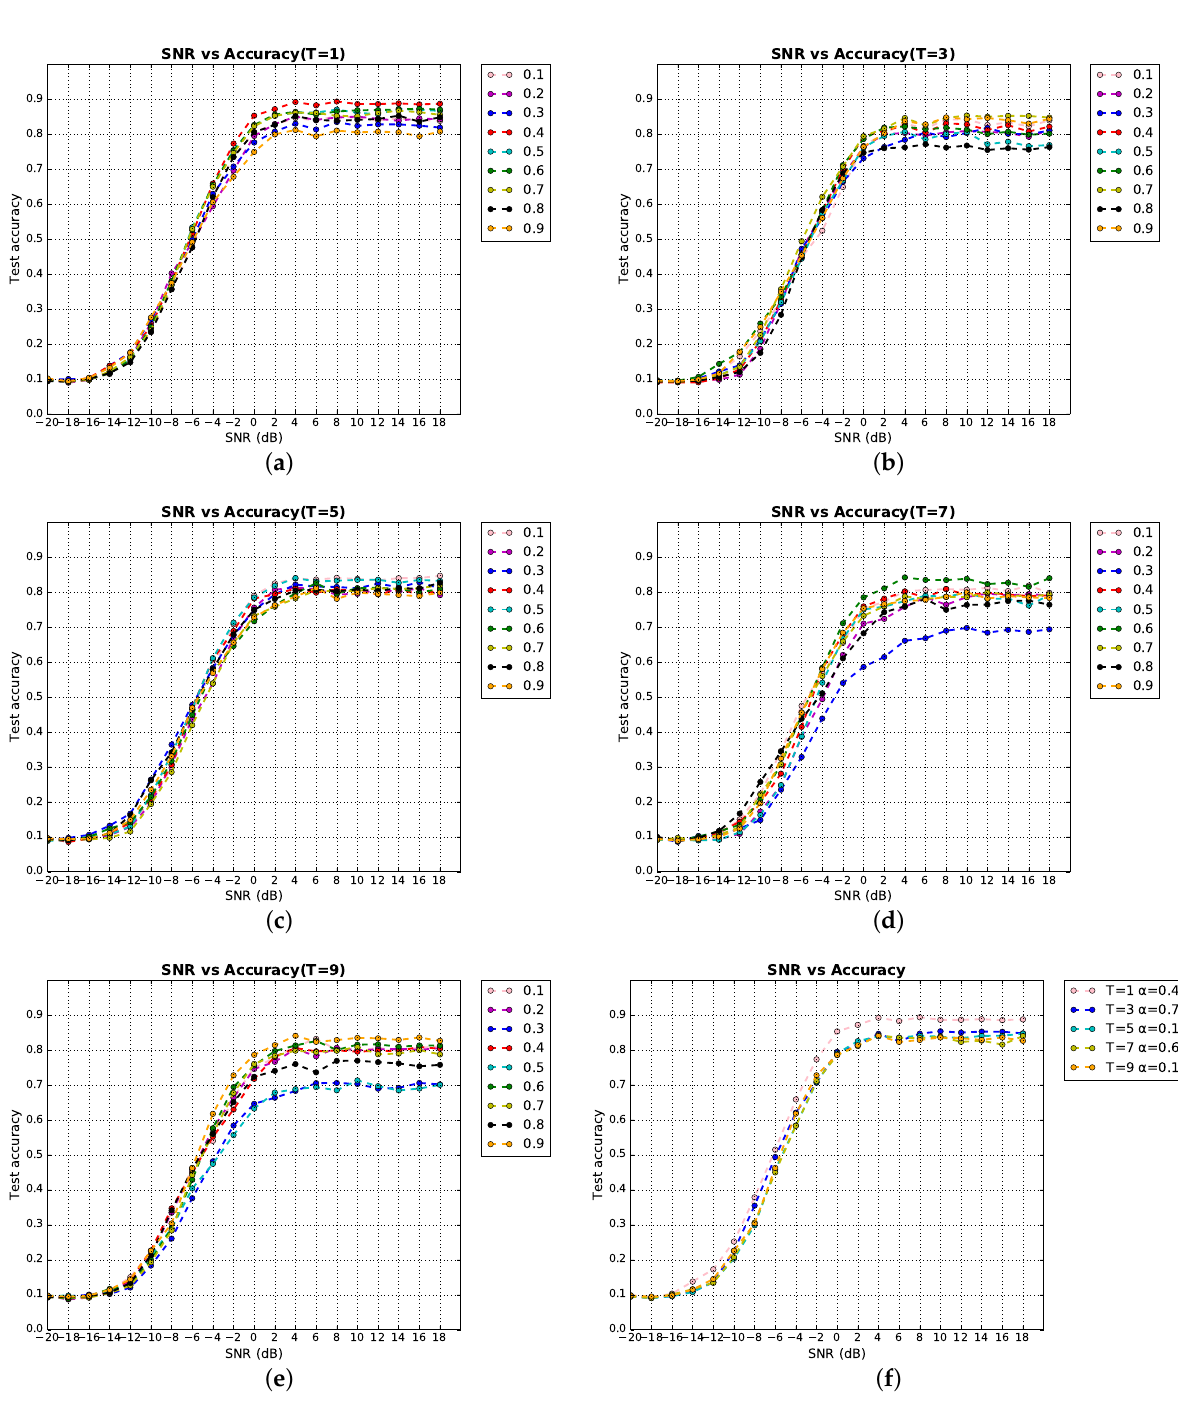
Figure 13. CNN3 classification accuracy after knowledge distillation with different parameters. ( a ) Classification accuracy of student networks corresponding to different α at T = 1; ( b ) at T = 3; ( c ) at T = 5; ( d ) at T = 7; ( e ) at T = 9; and ( f ), the best classification accuracy in each